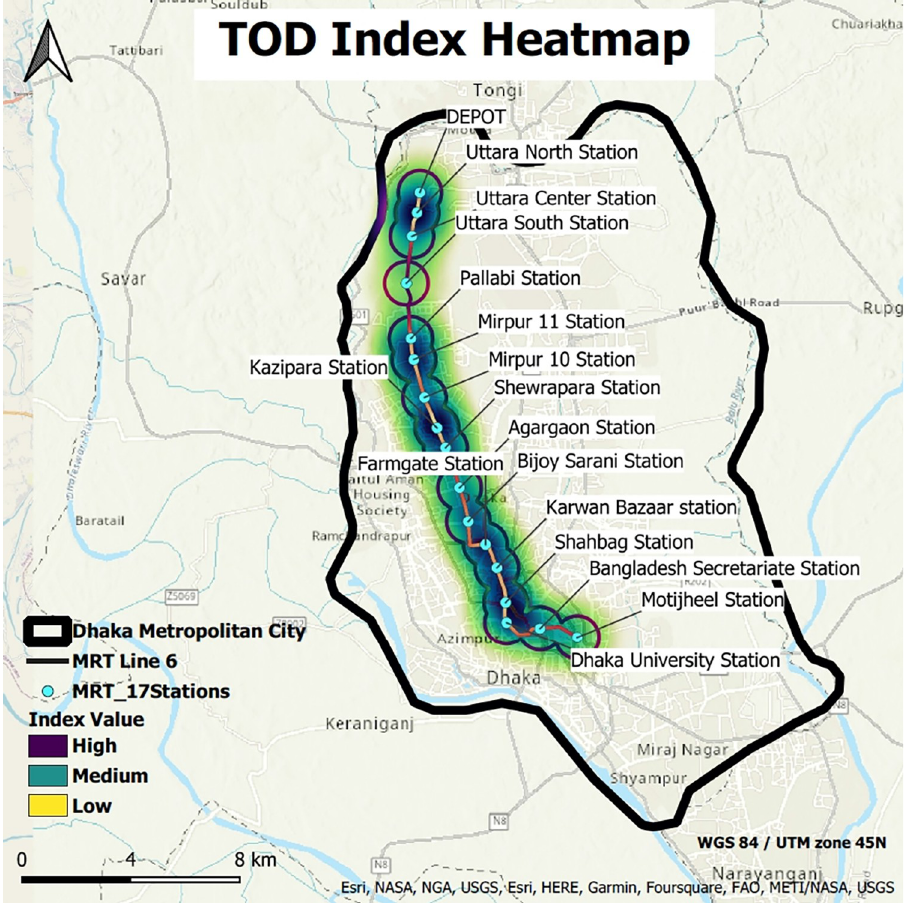
Fig 7. Heatmap of TOD index (source: Map is prepared by authors using base map from https://apps. nationalmap.gov/viewer). Figure is similar but not identical to the original image and is therefore for representative purposes